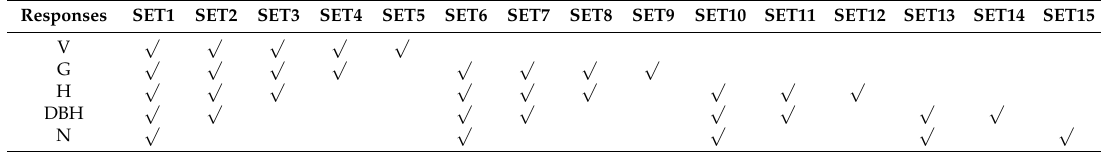
Table 3. Response configurations for k-nearest neighbor (KNN) imputation in this